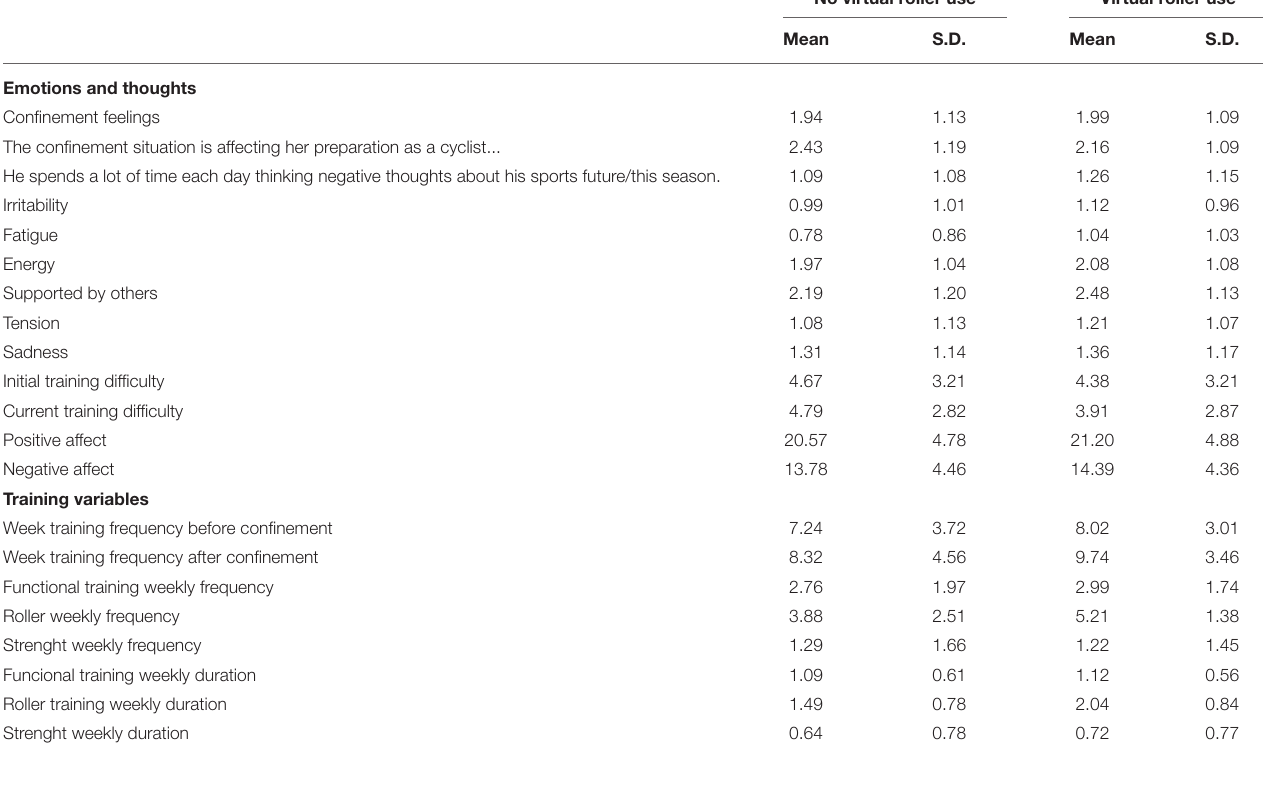
TABLE 3 | Mean and standard deviation (SD) of cyclists that employed (or not) virtual roller during